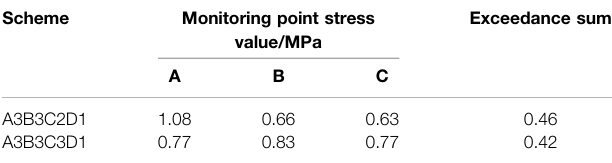
TABLE 8 | Contrast of tensile strength.